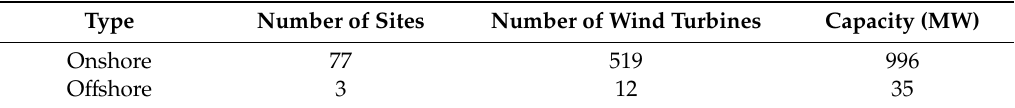
Table 1. Breakdown of wind data for 2016.